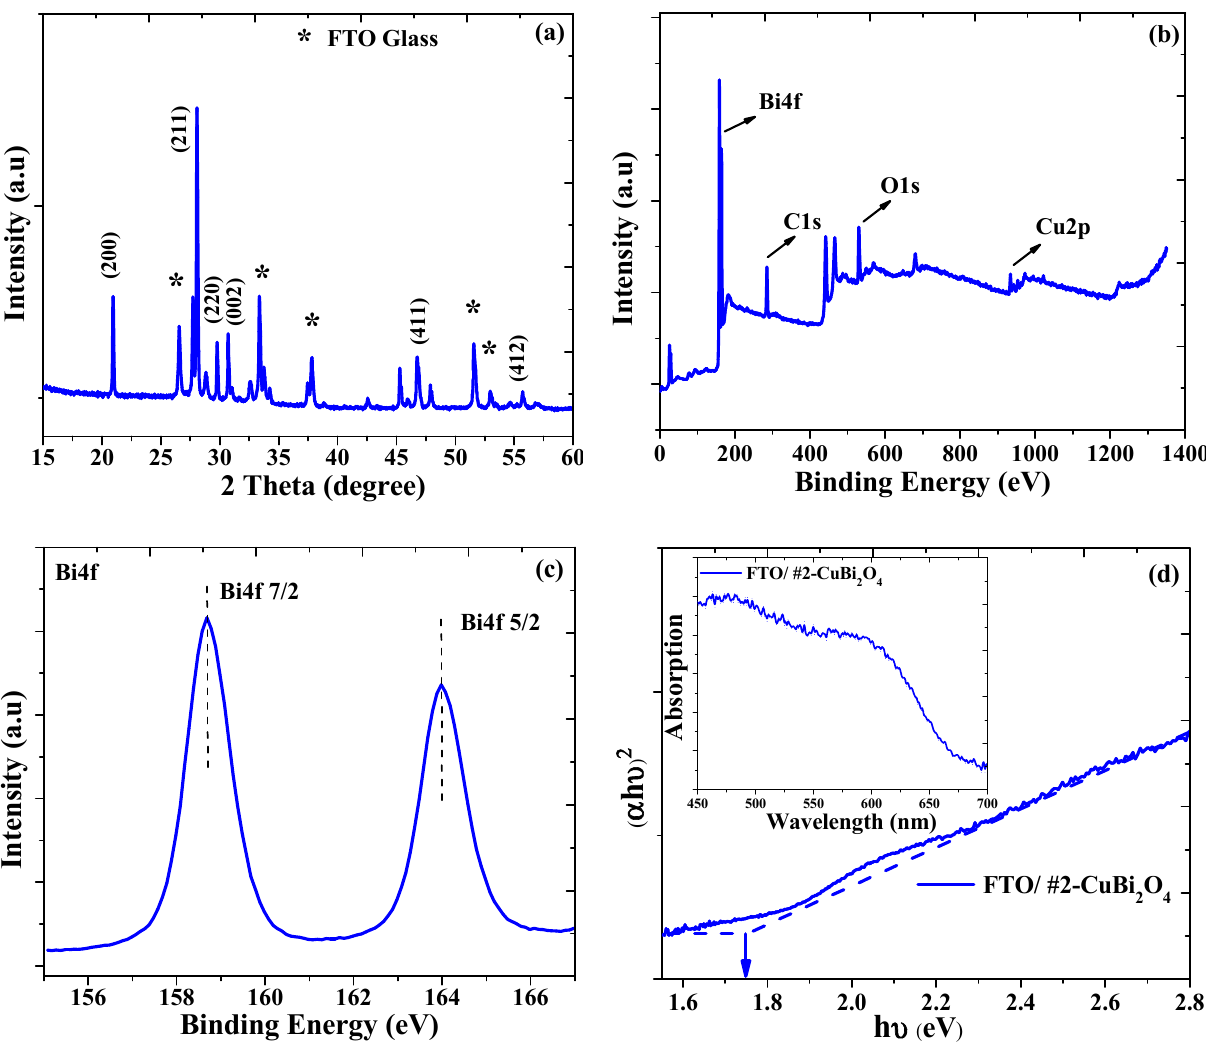
Figure 3. ( a ) XRD patterns, ( b ) XPS full-scan survey, ( c ) high-resolution XPS peaks for Bi 4f, and ( d ) band gap of the #2-CuBi 2 O 4 photocathode.